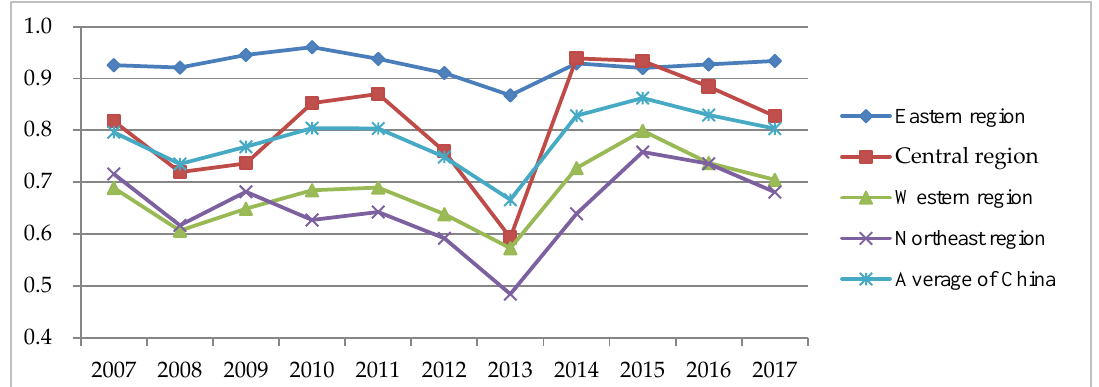
Figure 2. Change trend of TE values in each region of China (2007–2017).